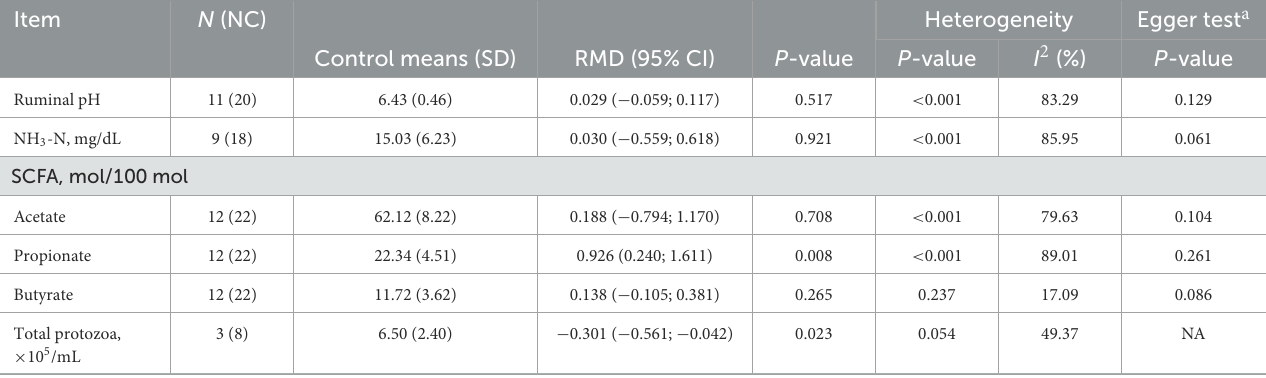
TABLE 4 Ruminal fermentation of cattle supplemented with